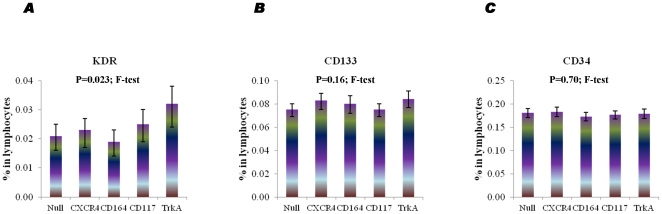
Representative graphs showing the interference of different fluorophore-conjugated antibodies.Different PE-labelled antibodies were added to KDR-FITC, CD133-APC and CD34-PECy7 in individual samples. Triplicate tests were performed. Data are presented as geometric means with 95% confidence intervals.